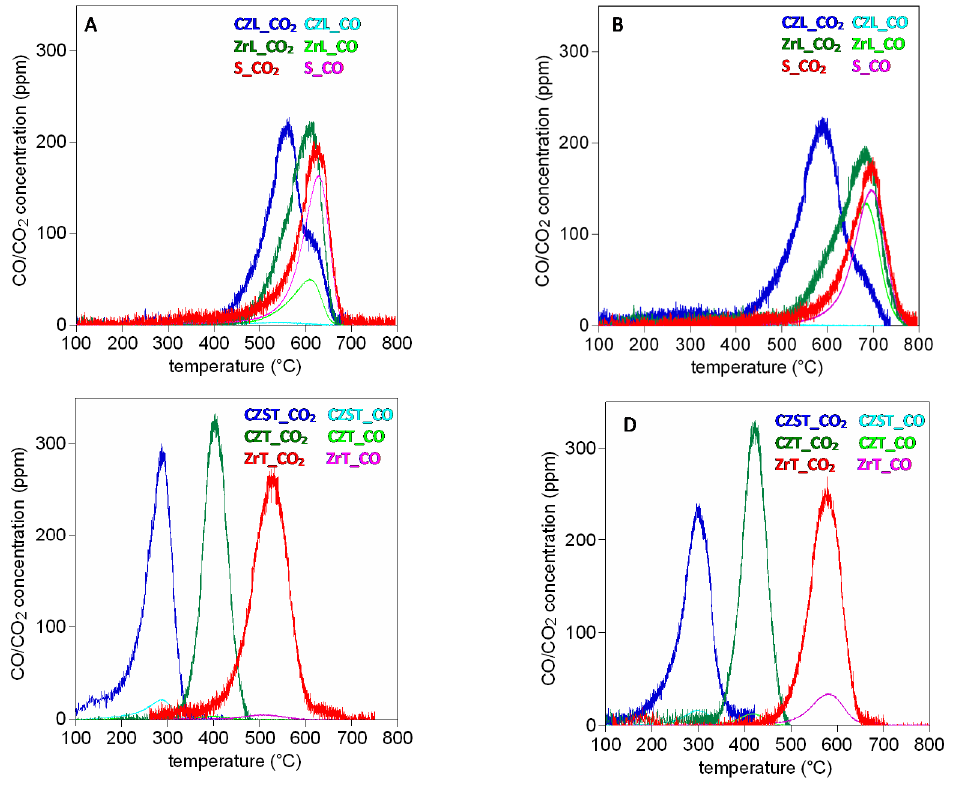
Figure 6. CO / CO 2 profiles from temperature programmed oxidation (TPO) in 10% O 2 / N 2 ( A , C ) and 1% Figure 6. CO/CO 2 profiles from temperature programmed oxidation (TPO) in 10% O 2 /N 2 ( A , C ) and O 2 / N 2 ( B , D ). 1% O 2 /N 2 ( B , D ). Table 2. CO 2 selectivity from TPO experiments.